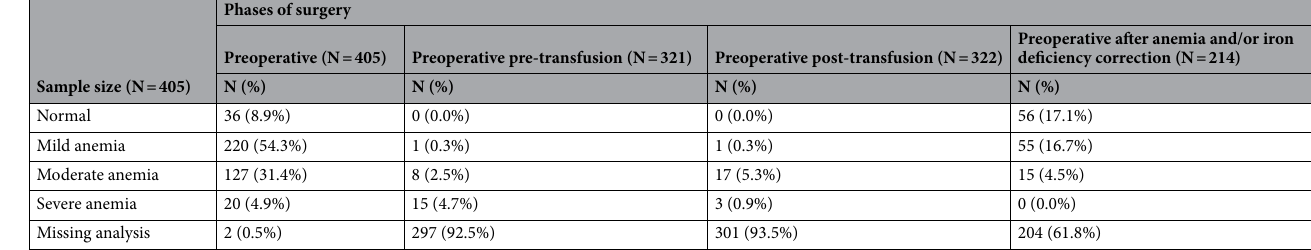
Table 2. Number of patients according the different types of anemia at preoperative period, including pre and post transfusion moments, and after the treatment of anemia/ iron deficiency